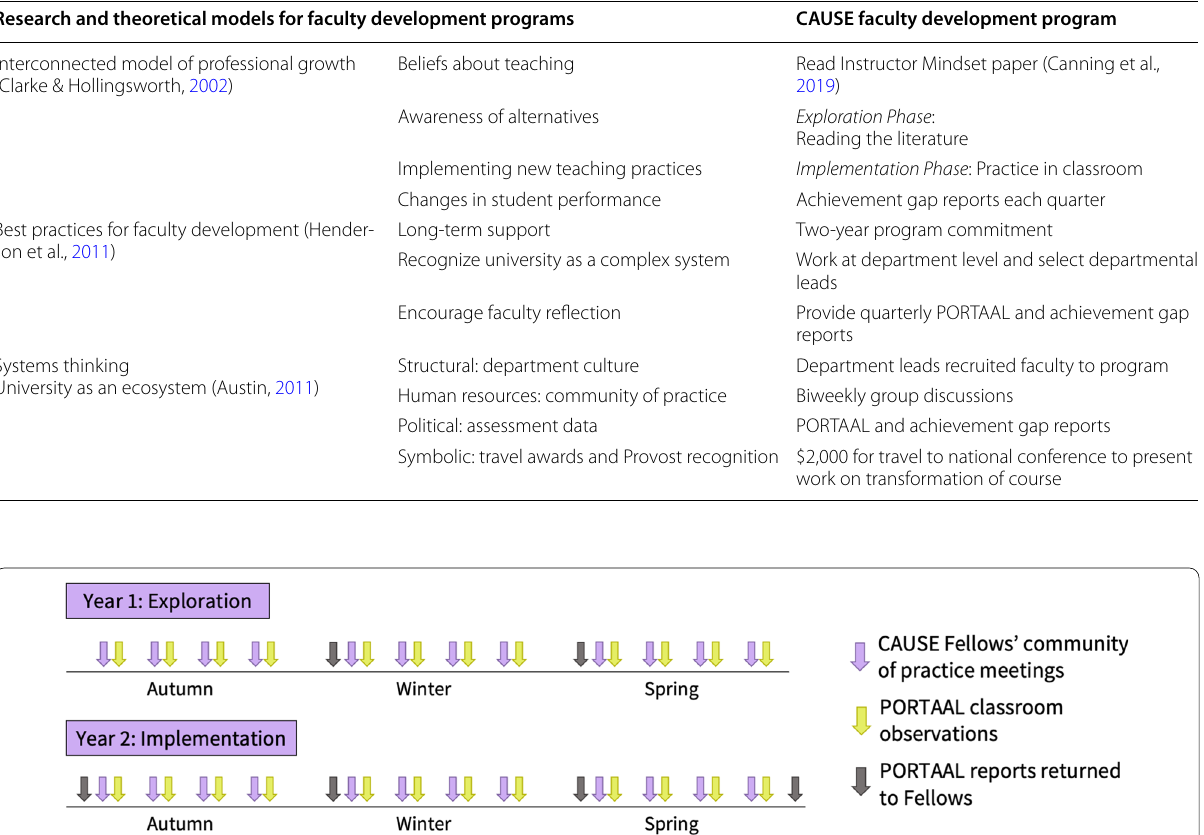
Table 1 Features of CAUSE from the primary